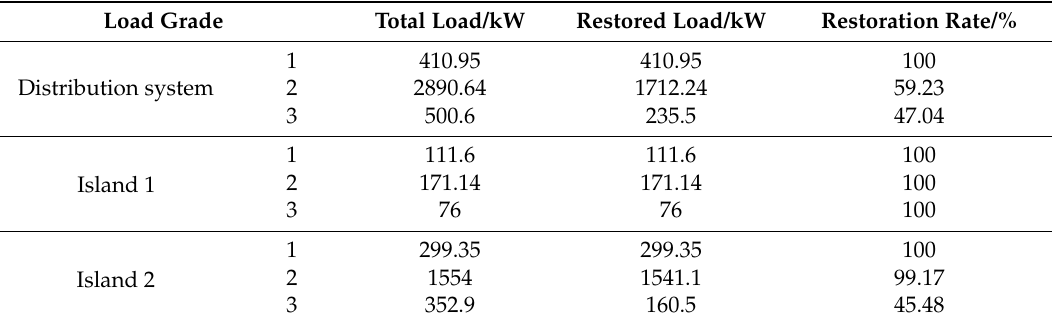
Table 4. Load restoration information.